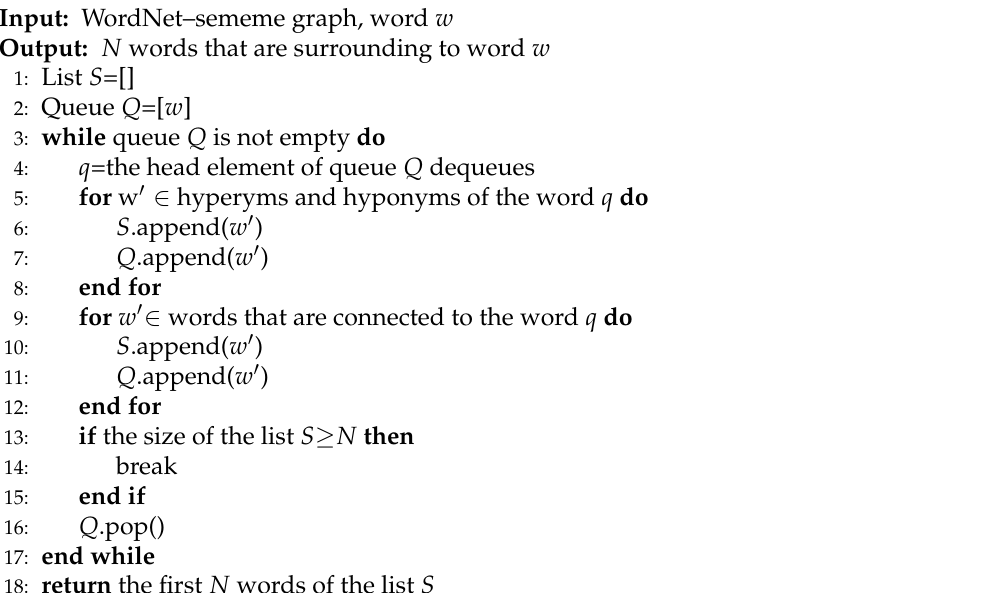
Algorithm 2 Get context words from the built WordNet–sememe